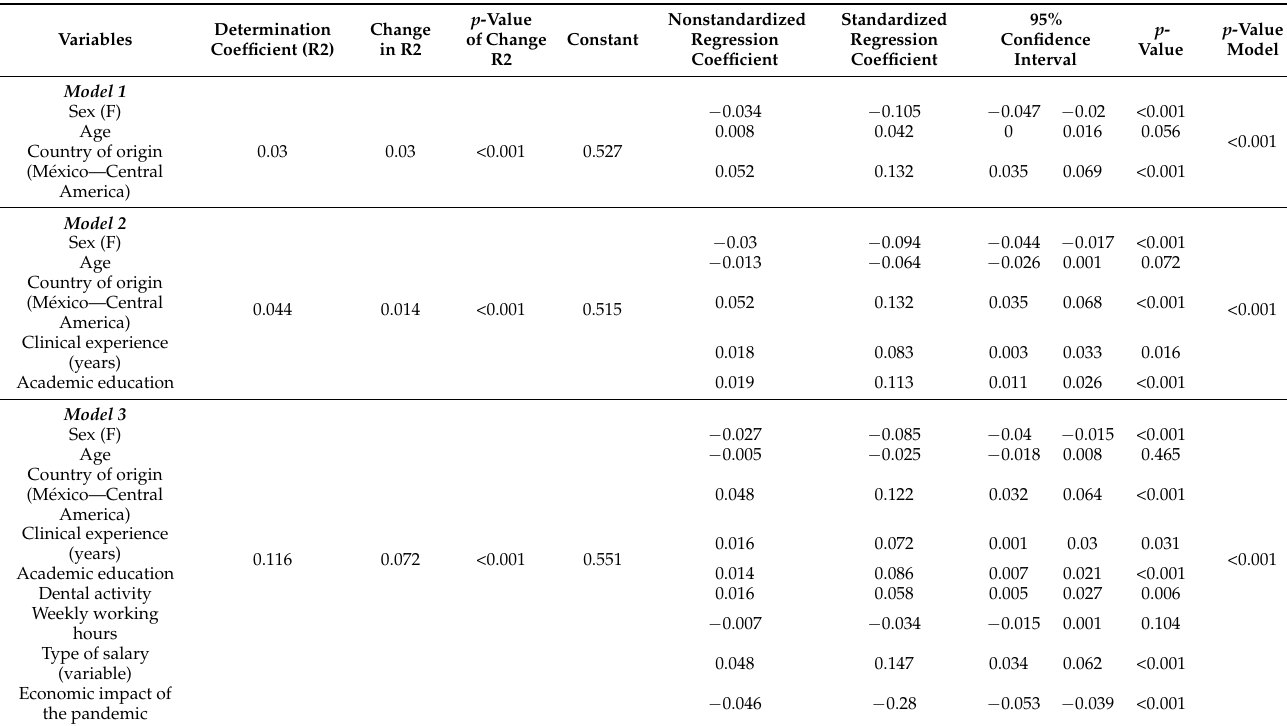
Table 5. Multiple linear regression model of the psychosocial well-being of dentists (n = 2214).